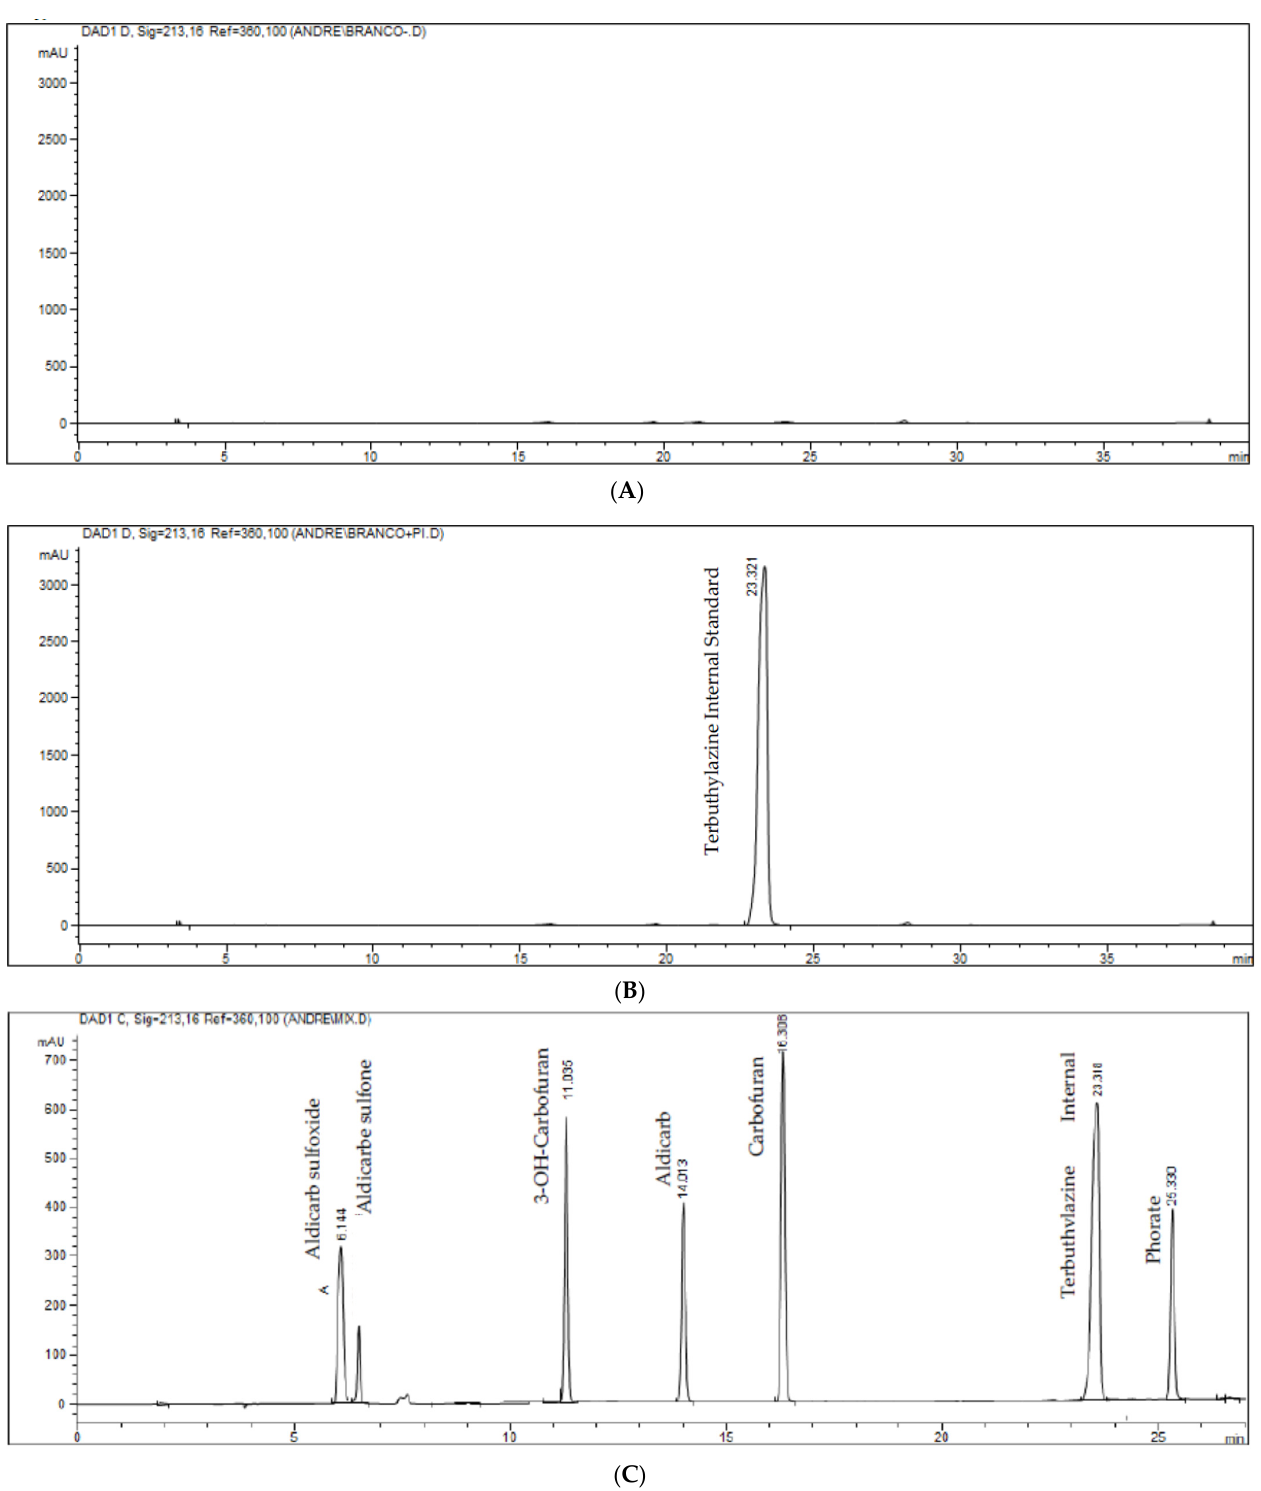
Figure 3. ( A – C ). Chromatograms of white samples represented in figure ( A ), zero (white sample added to the internal standard) represented in figure ( B ) and standards (aldicarb–sulfoxide, aldicarb–sulfone, aldicarb, 3-OH-cabrofuran, carbofuran, internal standard and phorate) represented in figure ( C ). The pattern was added to a pool of all matrices evaluated.